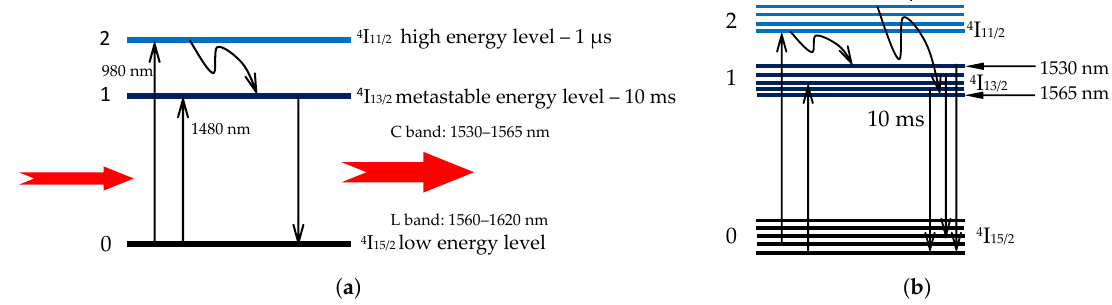
Figure 6. ( a ) Schematic diagram of erbium energy levels and ( b ) detailed energy levels for